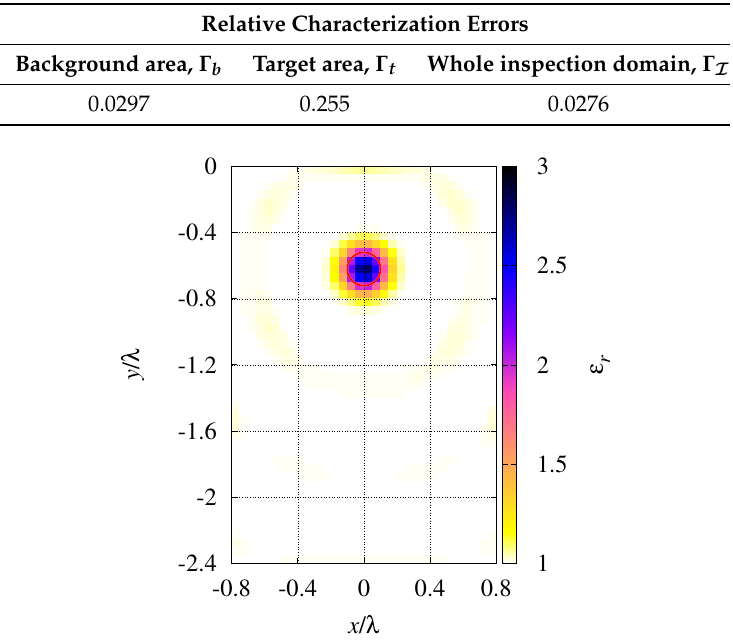
Figure 11. Mapping from experimental data. Reconstructed distributions of the relative dielectric permittivity of the region under